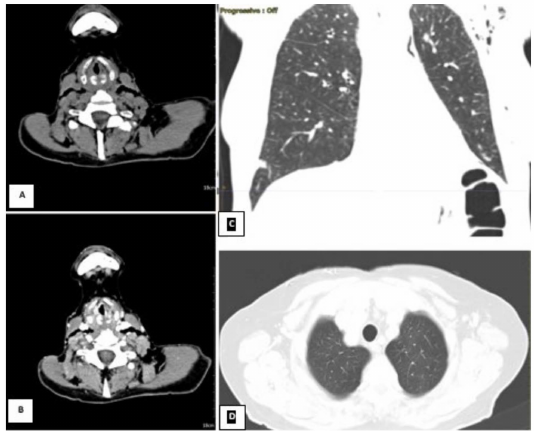
Figure 4. CT scan on the left. The neck scan revealed the presence of small submucosal bilateral glottic masses, associated with increased cervical lymph node volume, without subglottic and extra laryngeal extensions. ( A ) Axial section basal CT scan on the left. ( B ) Axial contrast-enhanced CT on the right. Lung window showing a small scar at the level of the right lower lobe from previous pneumonia reported by the patient; ( C ) coronal and ( D ) axial lung window). Due to the